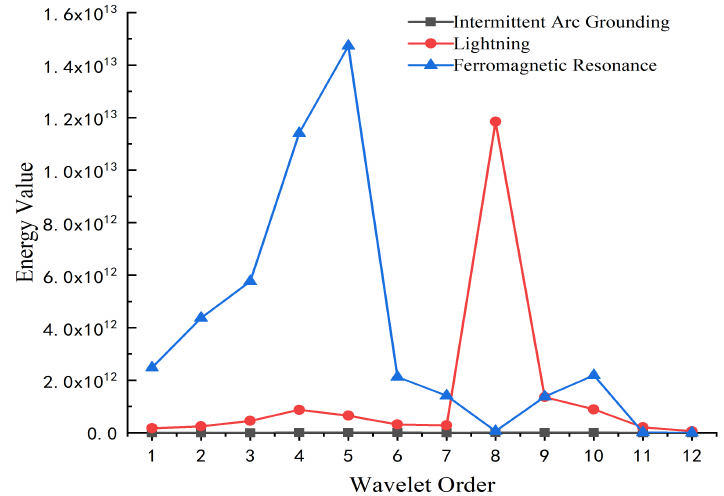
Figure 11. Wavelet energy values of intermittent arc grounding, lightning, and ferromagnetic reso- nance overvoltage. Table 3. Characteristic parameters of three kinds of